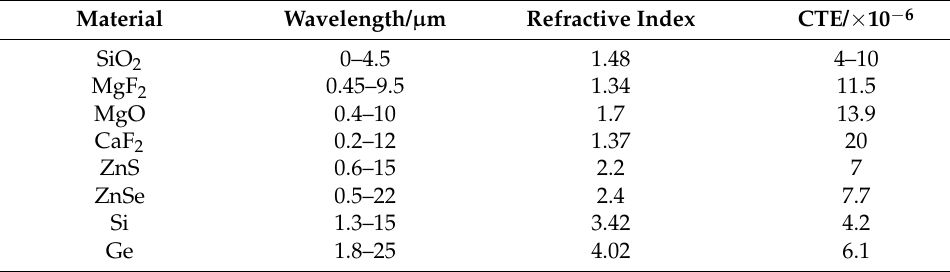
Figure 9. Schematic diagram of cold-stop matching of infrared optical system. Table 2. Optical and thermal properties of infrared materials.